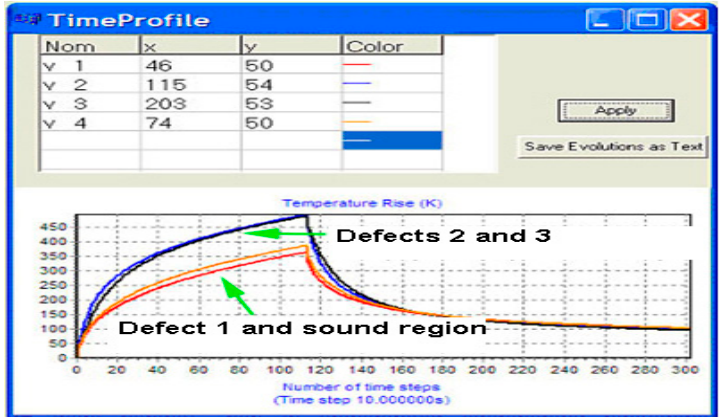
Figure 6. Temperature—Time plot from the modelling runs.